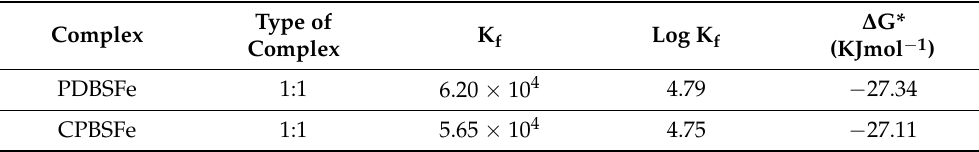
Table 3. The constant of formation (Kf), constant of stability (pK), and Gibbs free energy ∆ (G*) values for the investigated Fe(III) chelates at 298